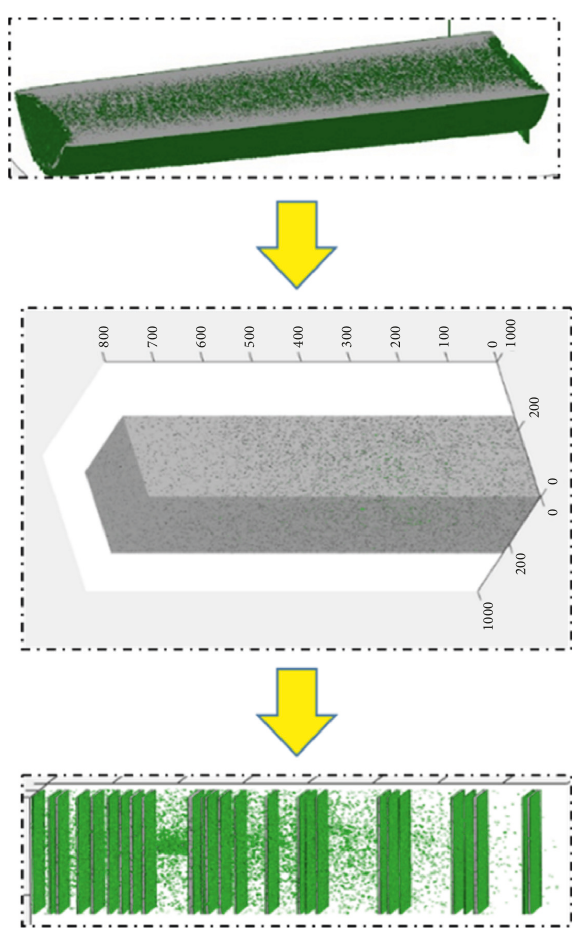
Figure 3: Invalid area and effective area